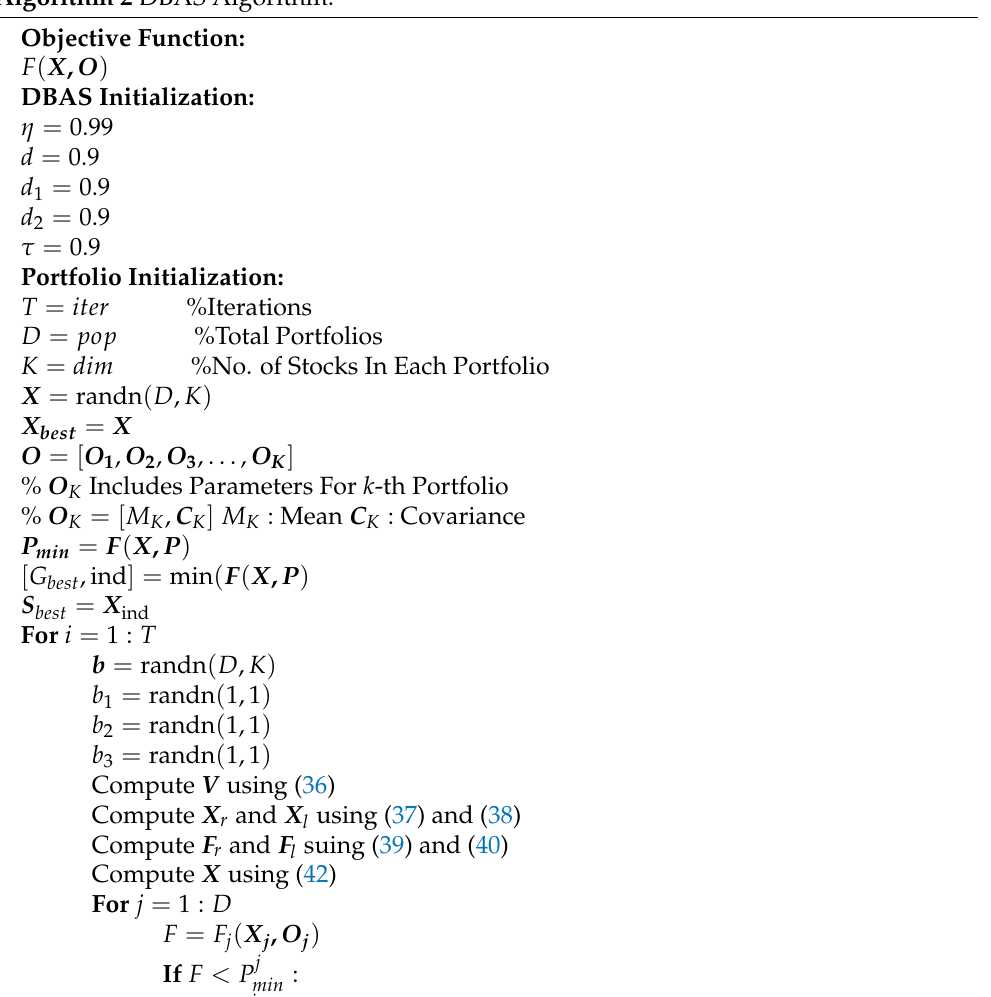
Algorithm 2 DBAS